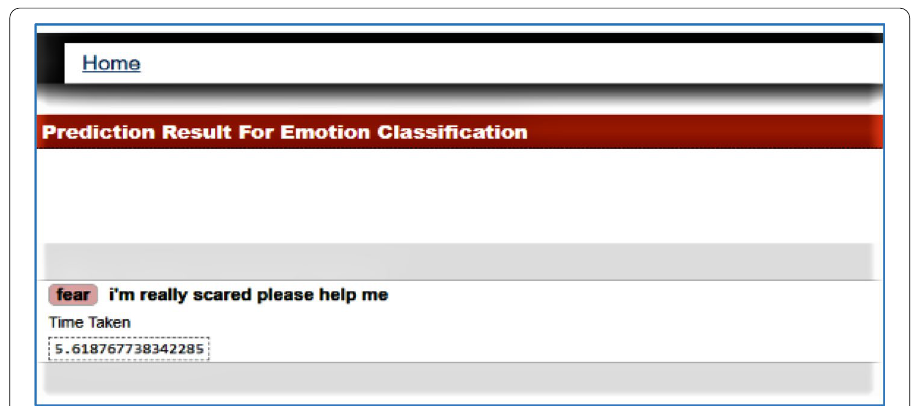
Fig. 27 Fear Tweet with the time taken 5